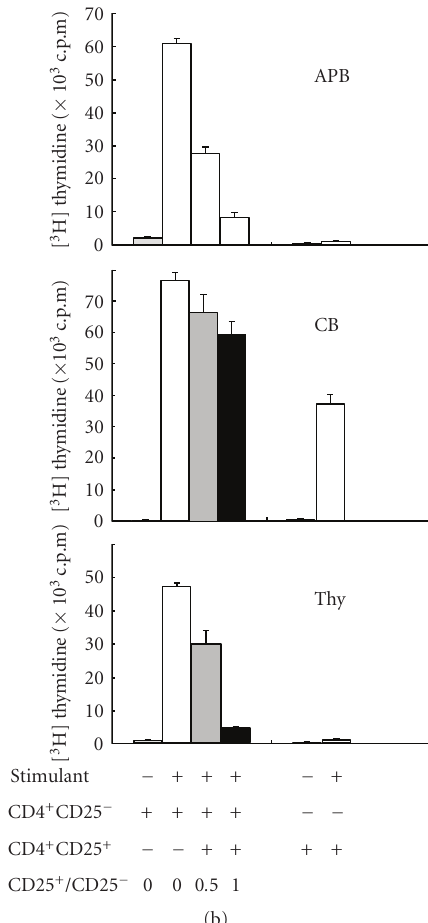
level of FOXP3 protein, with this population being